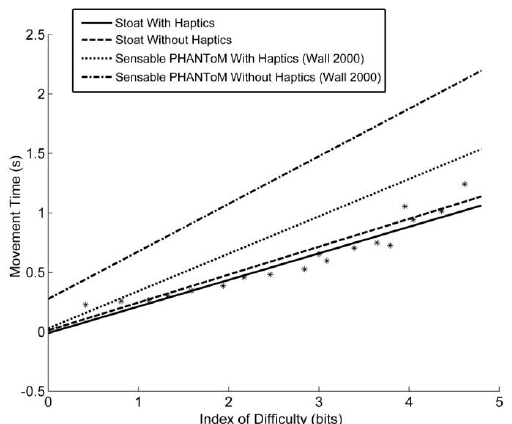
Figure 13. Comparison of haptic and non-haptic Fitts’ Law regression slopes between the PHANToM Premium 1.5 and the coupled system (Stoat). For reference the mean data points are plotted for the “Haptics on” condition on the Stoat.